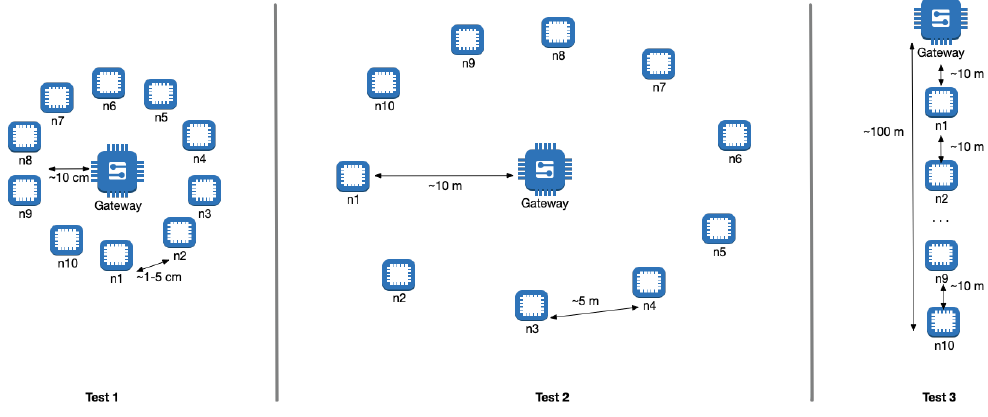
Figure 8. Setup of group messaging